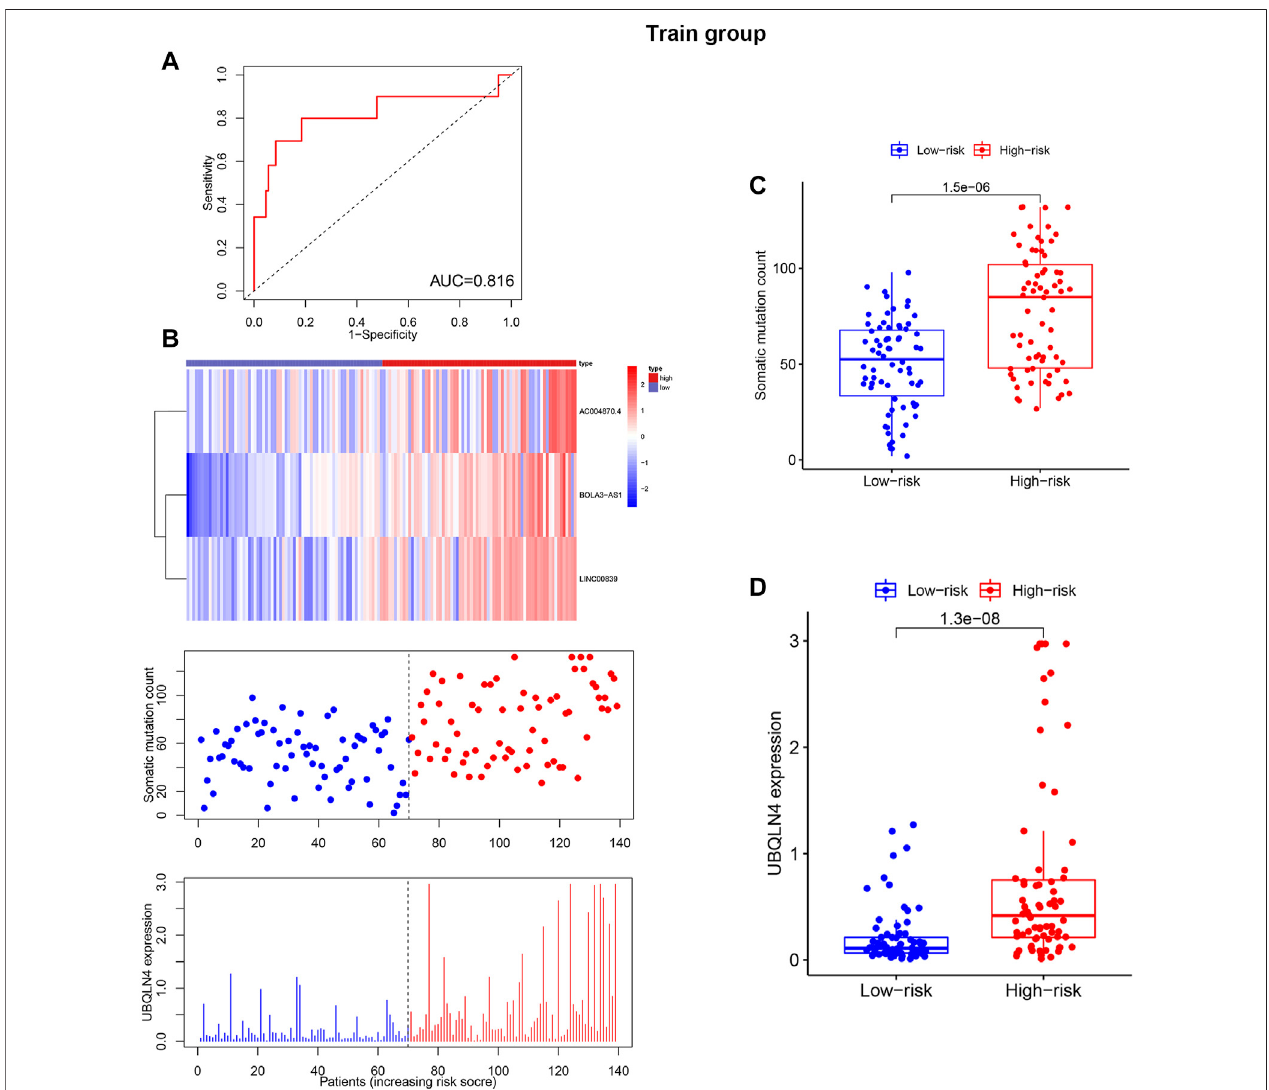
FIGURE 4 | Independent validation of GILncSig in the training set with RNA-seq platform. (A) . Time receiver operating characteristic curve analysis of GILncSig in the training set at 3 years. (B) . lncRNA expression patterns, somatic mutation distribution and UBQLN4 expression based on the increasing trend of GILncSig score. Additionally, total somatic mutation distribution with increasing GILncSig score is displayed. (C) . Comparison of the total number of somatic mutations in different GILncSig groups. (D) . The expression level of UBQLN4 in various GILncSig groups.